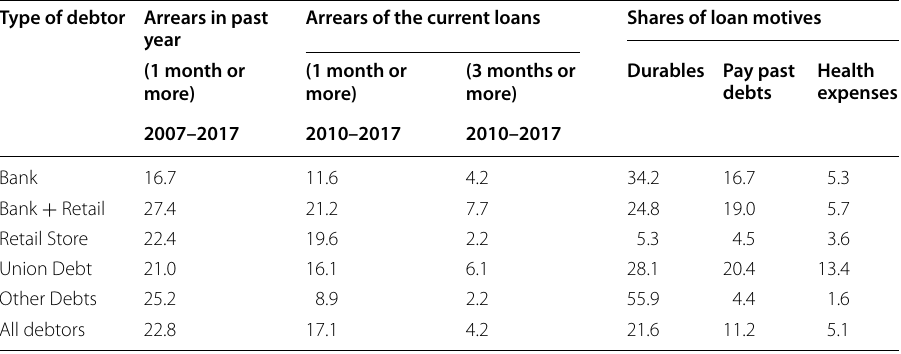
Table 4 Consumer loan arrears (in %) for each debtor type (all waves) and shares of each loan motive as a fraction of the total consumer debt (in %): averages across borrowers (all